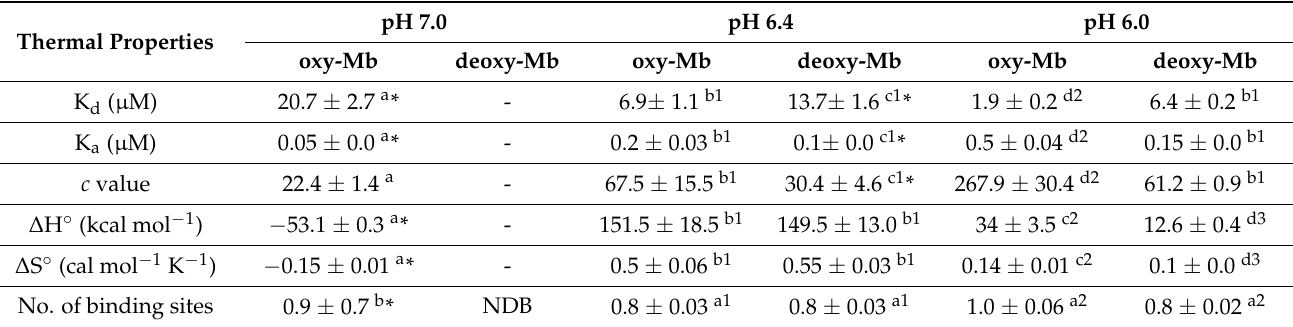
Table 1. Thermodynamic binding properties of lactate titrated against equine deoxy-Mb and oxy-Mb in ITC experiments in different pH conditions. Dissociation constant ( K d ), association constant ( K a ), the ratio of the receptor concentration, and the dissociation constant are determined by c